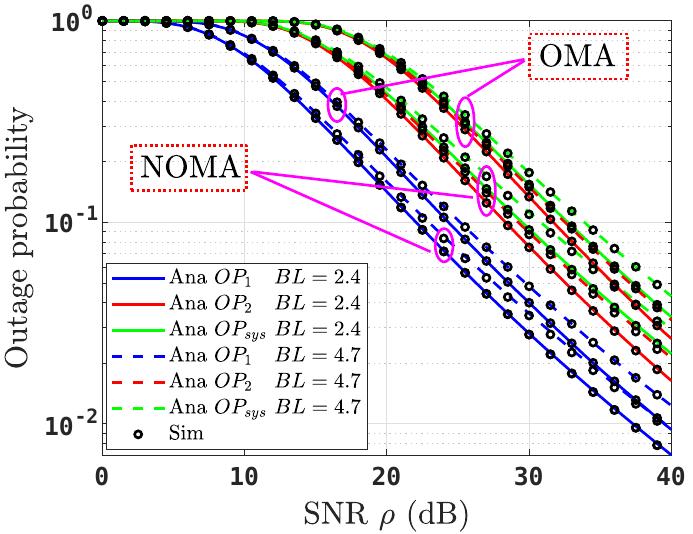
Figure 3. OPs versus SNR for thermally uniform UOWC links for varying air bubbles levels applicable to NOMA and OMA based